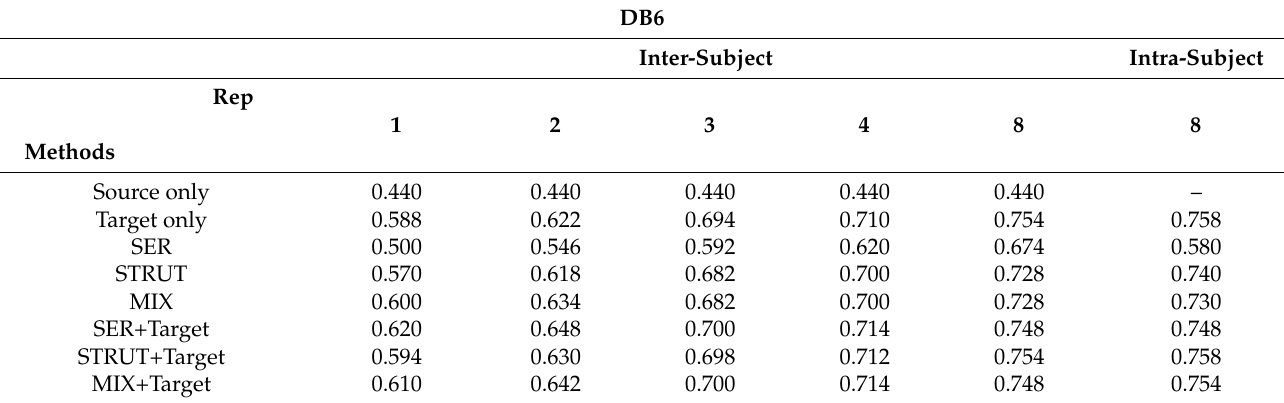
Table 3. Classification methods accuracy on datasets DB6 for each combination of subjects and for each